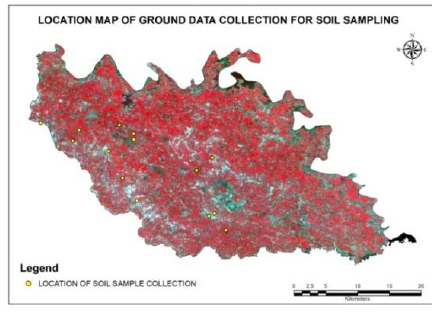
Figure 2: Locations for ground soil samples